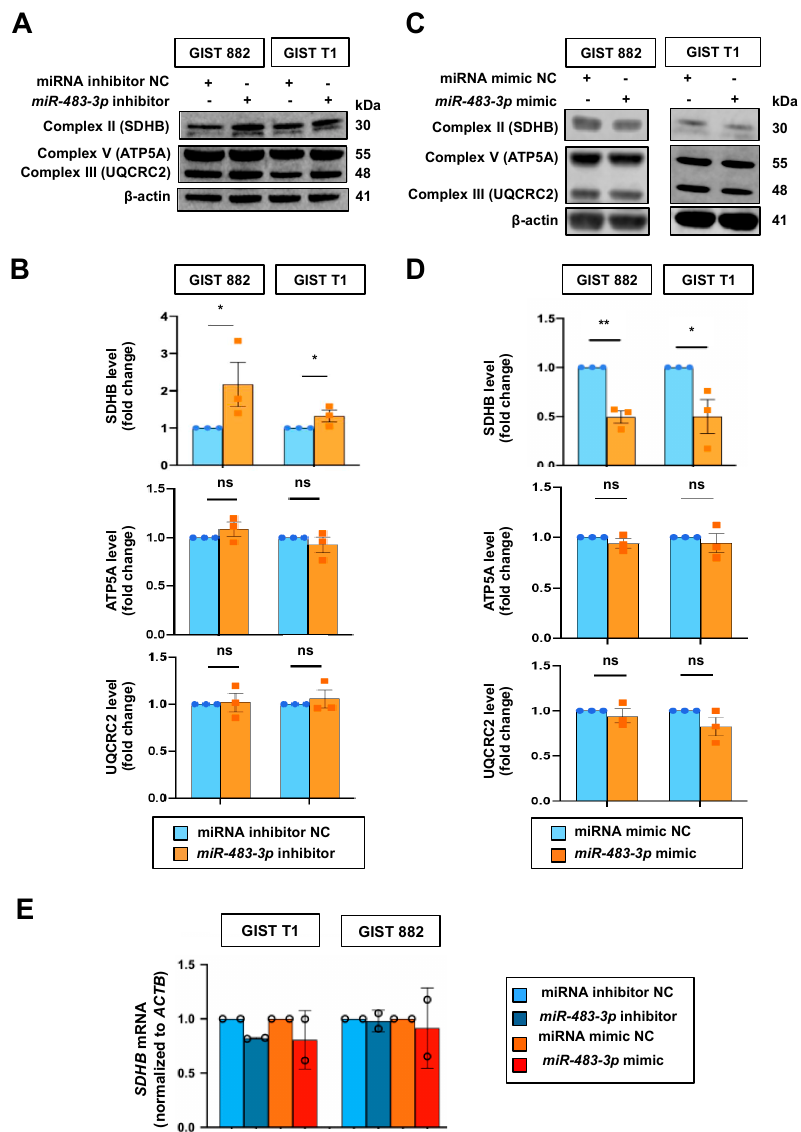
Figure 3. Effect of miR-483-3p overexpression and inhibition on oxidative phosphorylation (OXPHOS) protein expressions. ( A , C ) Representative Western blots showing OXPHOS proteins in GIST cell lines upon inhibition ( A ) or overexpression ( C ) of miR-483-3p and their respective non-targeting controls (NC) at 72 h post-transfection. Estimated protein sizes are given to the right of the blots in kiloDalton (kDa). ( B , D ) Bar plots showing quantification of OXPHOS proteins in ( A , C ). β -actin was used as a loading control. miRNA inhibitor and mimic non-targeting controls were set to 1.0. ( E ) RT-qPCR analysis of SDHB mRNA in GIST cells with overexpression or inhibition of miR-483-3p . Error bars refer to SD of two or three independent experiments. Differences between groups were calculated using paired t-test. * p < 0.05, ** p < 0.01, ns = not significant.